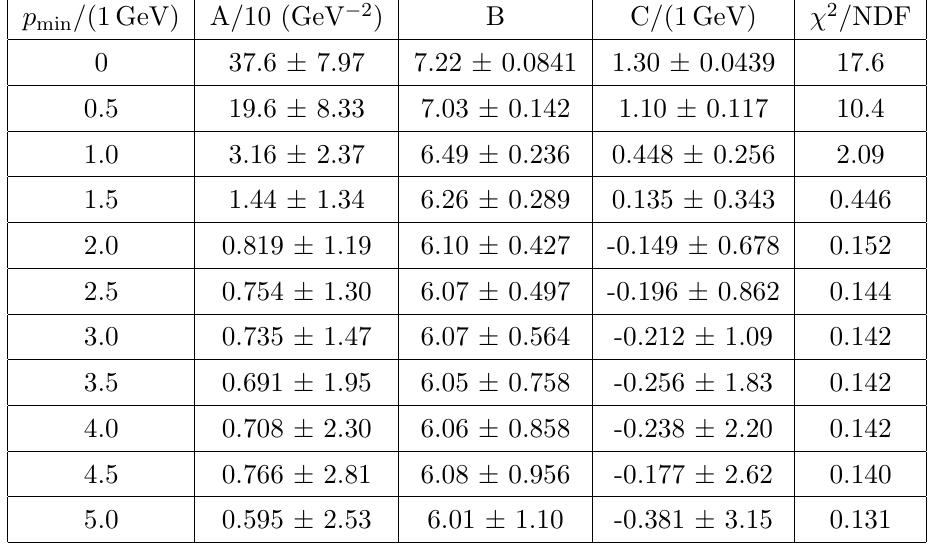
Table 9. Fitted values of parameters in eq. (E.3) for the ALICE dataset at p s = 5 : 02 TeV in